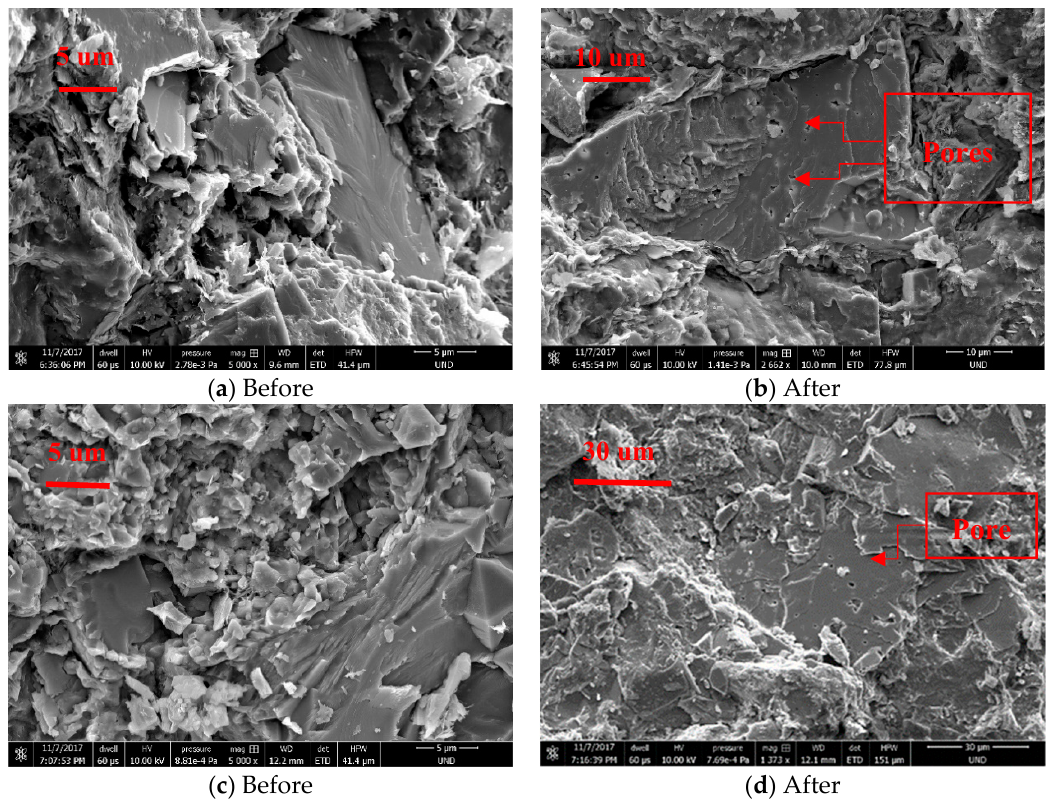
Figure 8. The scanning electron microscope (SEM) images of the sample before and after the CO 2 injection ( a ), ( b ) show the images of Sample 1 while ( c ), ( d ) show the images for Sample 2.